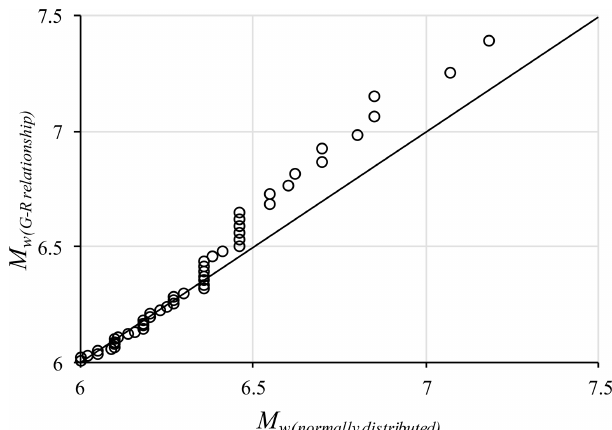
Figure 3. Q − Q plot of M w for Gutenberg–Richter law and the normal